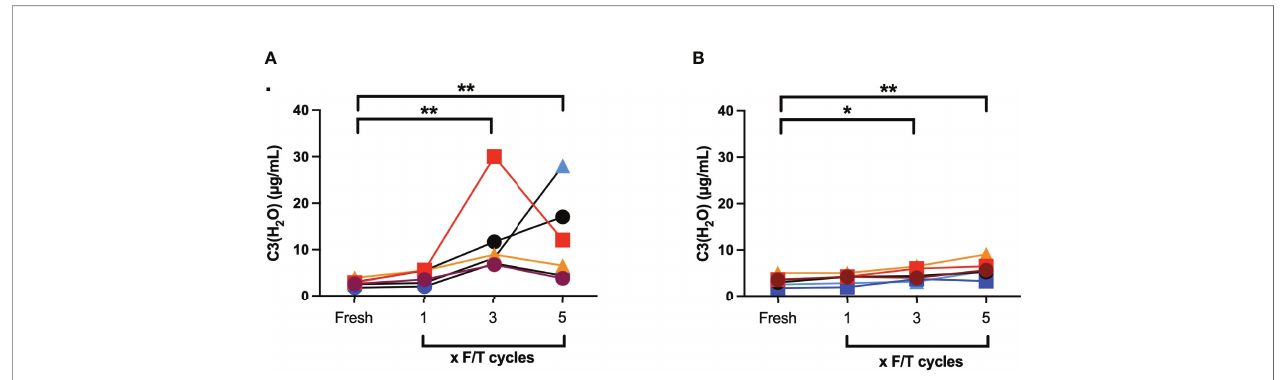
FIGURE 3 | Quanti fi cation of C3(H 2 O) by ELISA in EDTA plasma (n = 6) that were subjected to repeated F/T cycles: (A) -20°C to RT; (B) -80°C to 37°C. *: p <0.05; **: p <0.001.